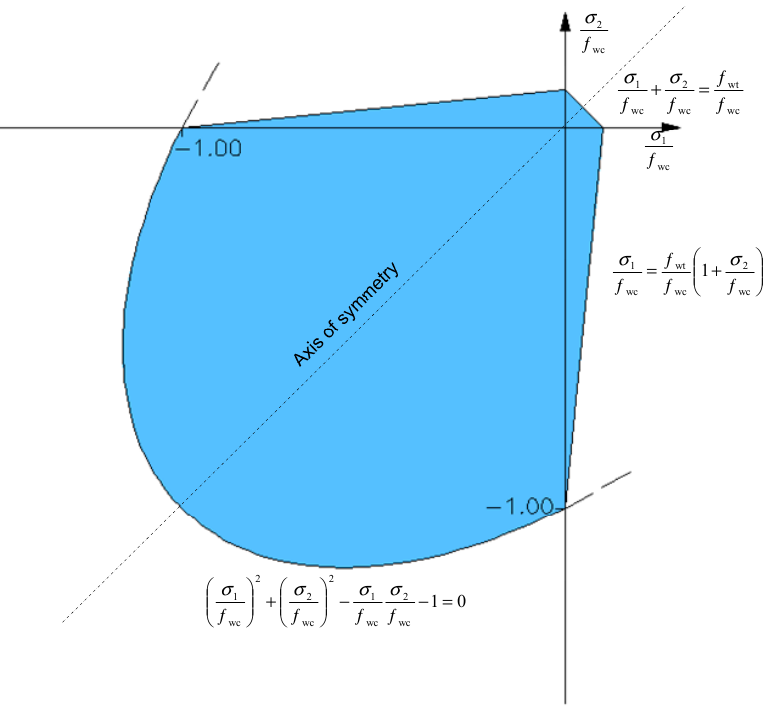
Figure 7. Kupfer and Gerstle isotropic failure criterion.